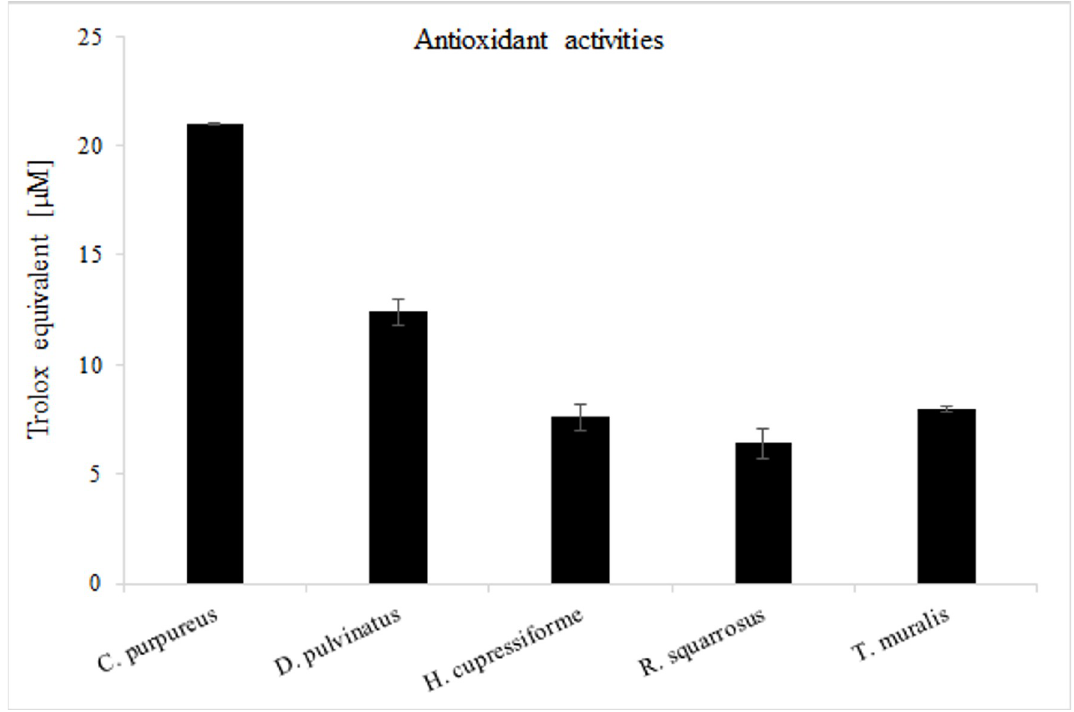
Fig 3. The ABTS cation scavenging activity of selected mosses extracts calculated as Trolox equivalent [ μ M]. The results are expressed as mean values of 3 independent experiments ± SD.